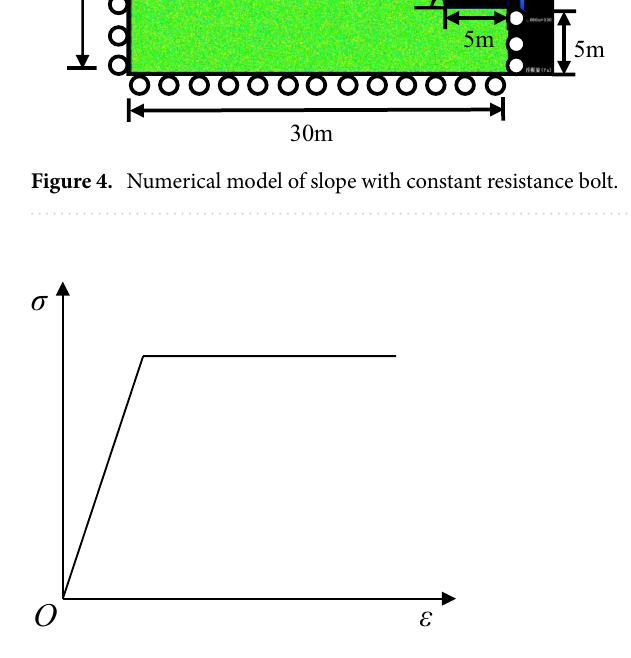
Figure 5. Elastic–plastic constitutive relation of constant resistance bolt.